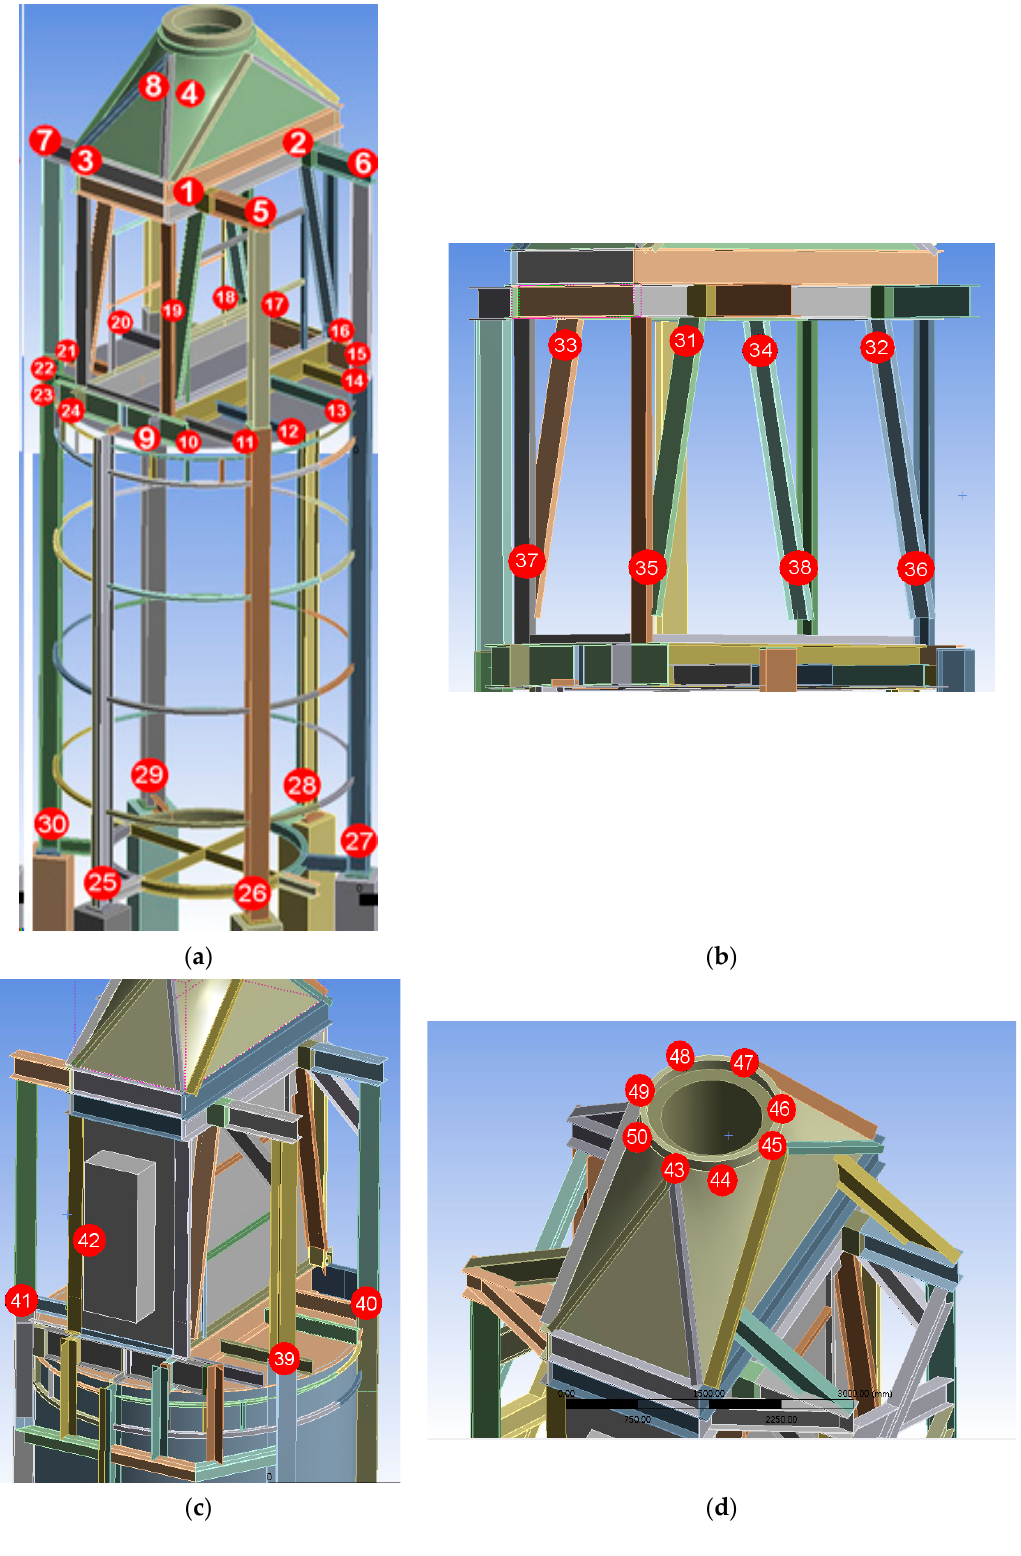
Figure 4. Illustration of the stress positions: ( a ) at the convection and radiation sections; ( b ) at the braces of the convection section; ( c ) at the junctions of the longitudinal beams; ( d ) near the root of the stack.